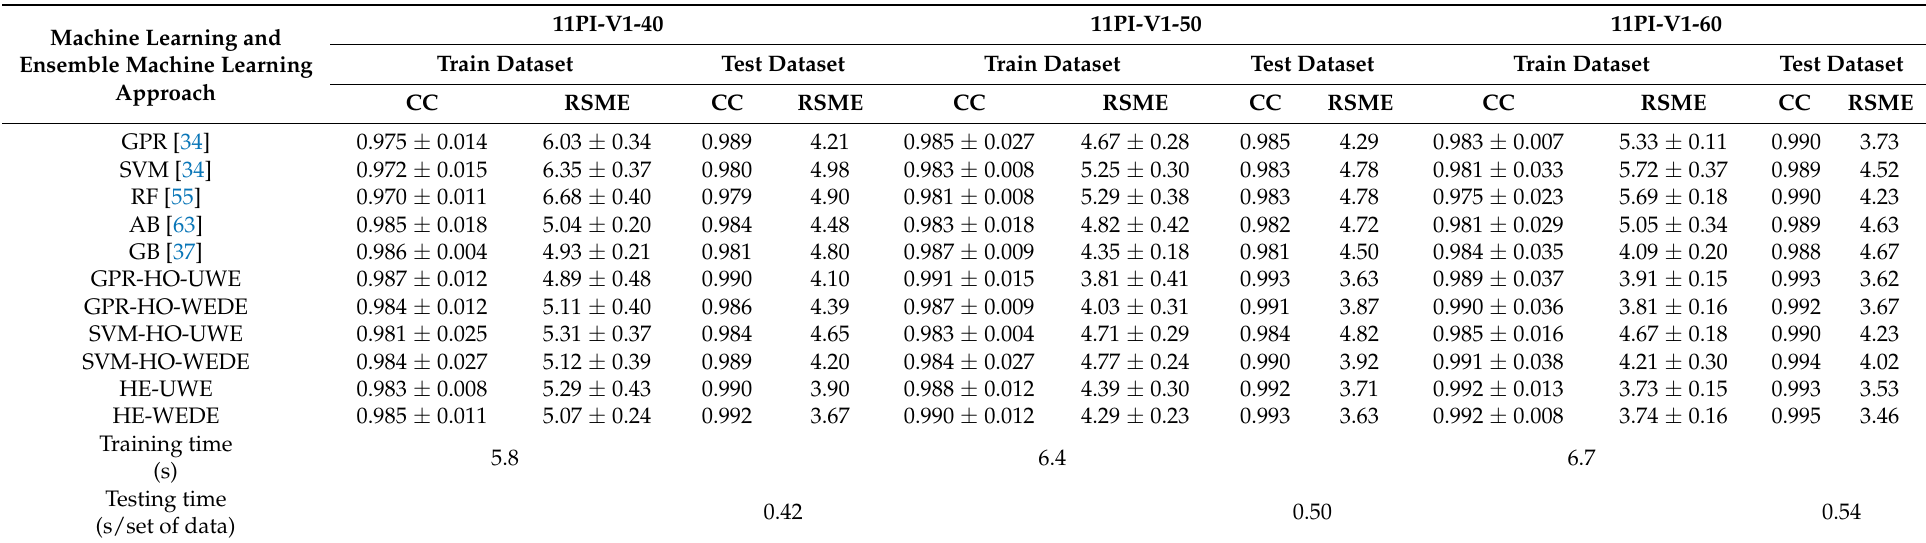
Table 12. Sensitivity test with different numbers of sets of